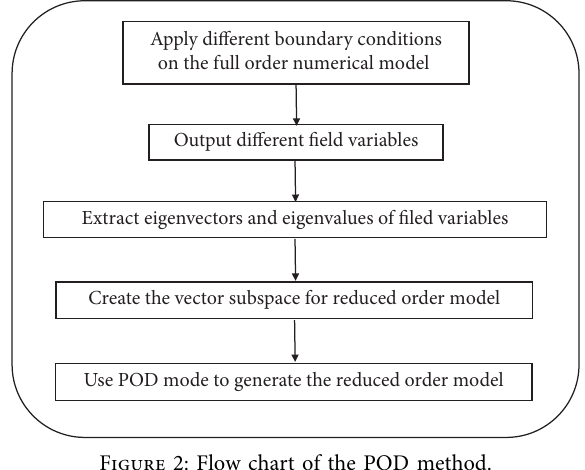
Figure 2: Flow chart of the POD method.